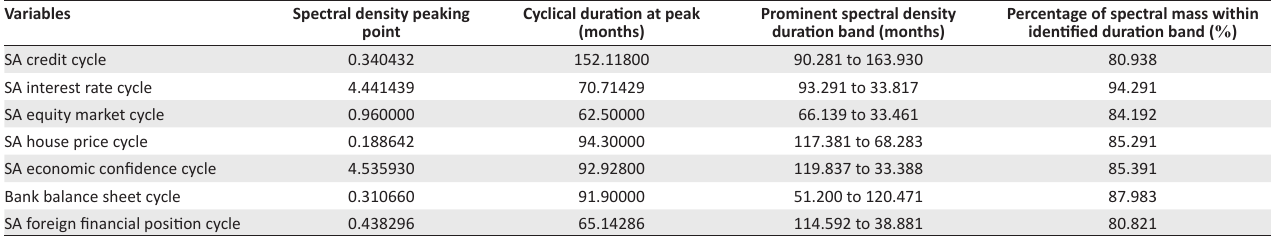
TABLE 9: Numerical results from spectral density analysis.